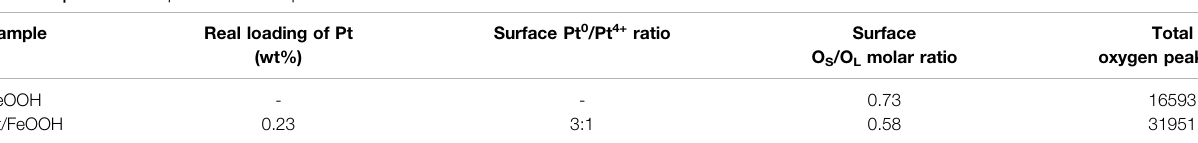
TABLE 2 | Surface compositions of